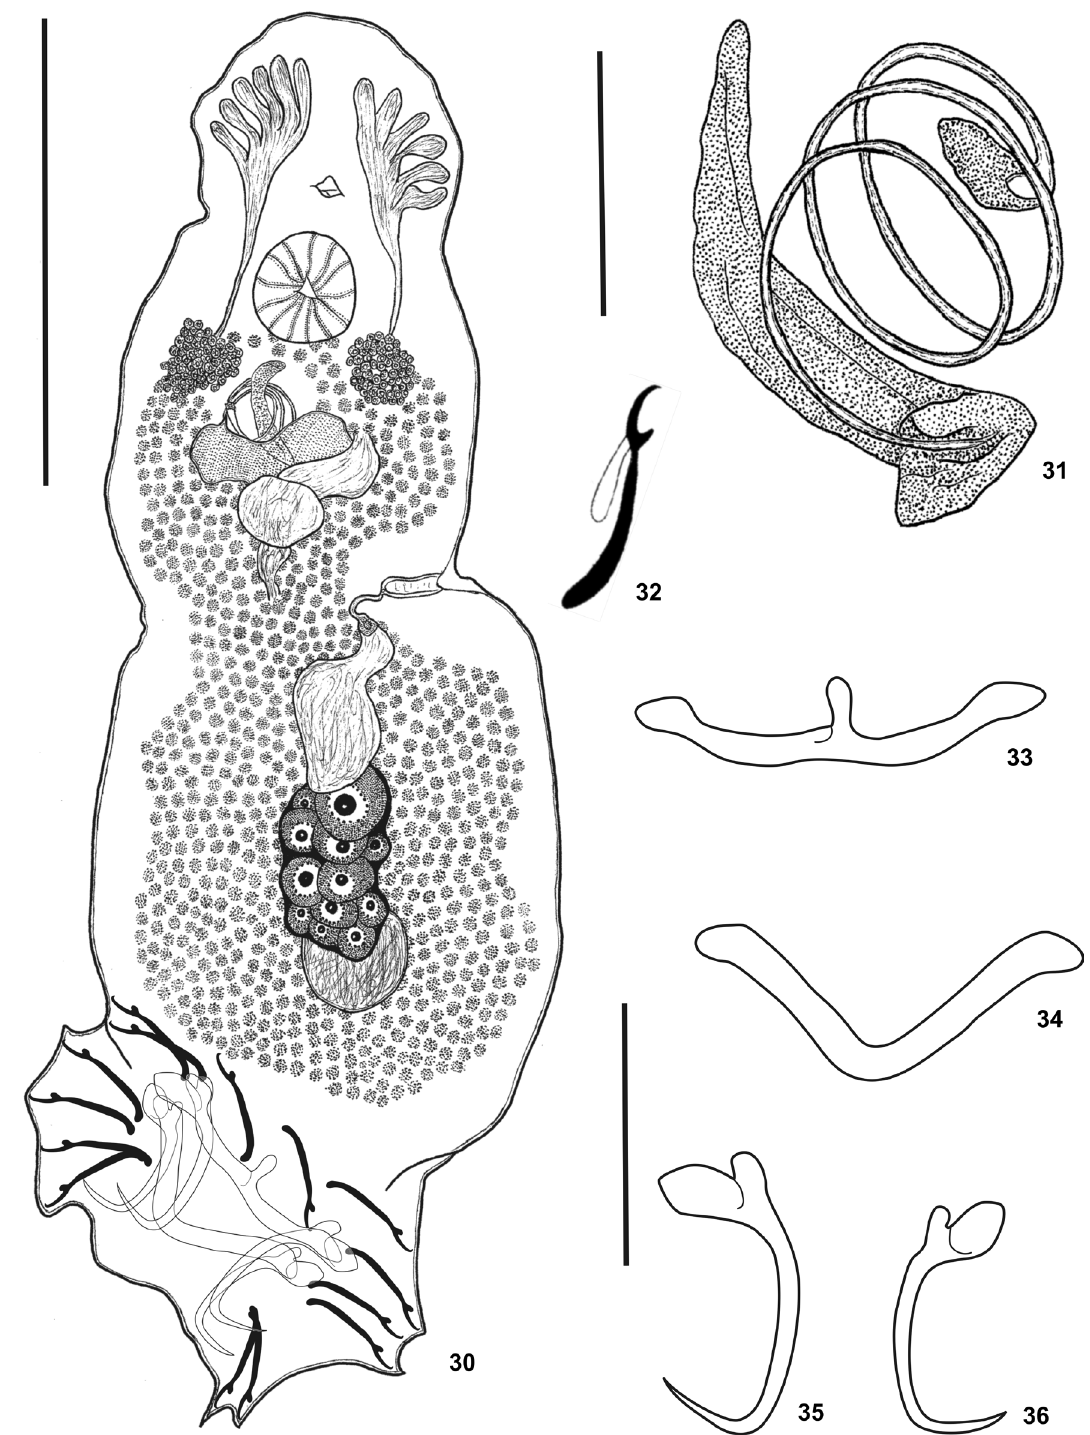
μm.Dactylogyrids Figures 30–36. Vancleaveus klasseni sp. nov.: (30) holotype whole-mount, ventral; (31) copulatory complex; (32) hook; (33) ventral bar; (34) dorsal bar; (35) ventral anchor; (36) dorsal anchor. Scale bars: 30 = 50 μm; 31 = 10 μm; 32–36 = 25 ZOOLOGIA 35: e23917 | DOI: 10.3897/zoologia.35.e23917 | June 29,